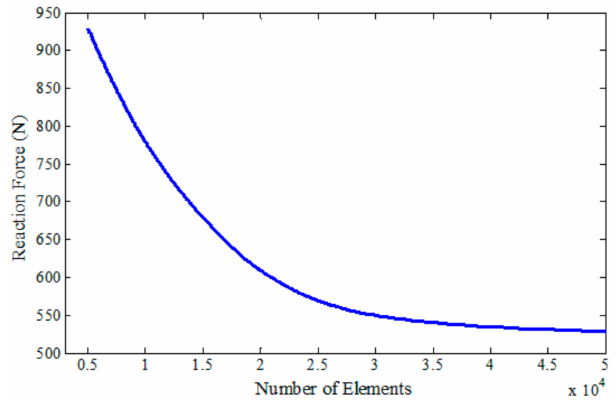
Figure 11. FEM mesh convergence test of the board with a uniform honeycomb core